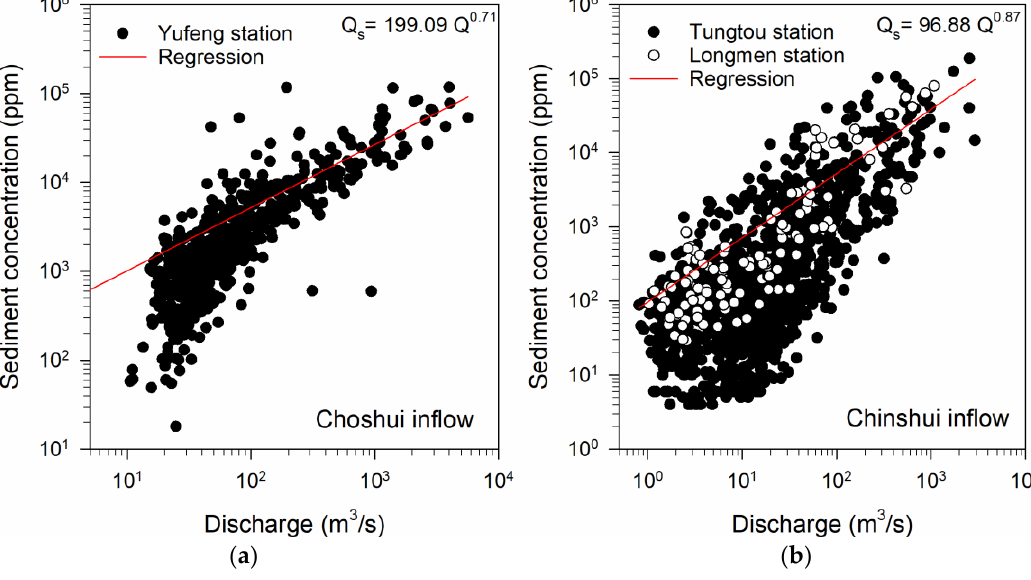
Figure 2. Rating curves of flow discharge and sediment concentration for ( a ) the Yufeng Bridge station (1994/2–2013/5), and ( b ) the Tongtou station (1994/6–2009/8) and the Longmen Bridge station (2009/10 – 2013/5).